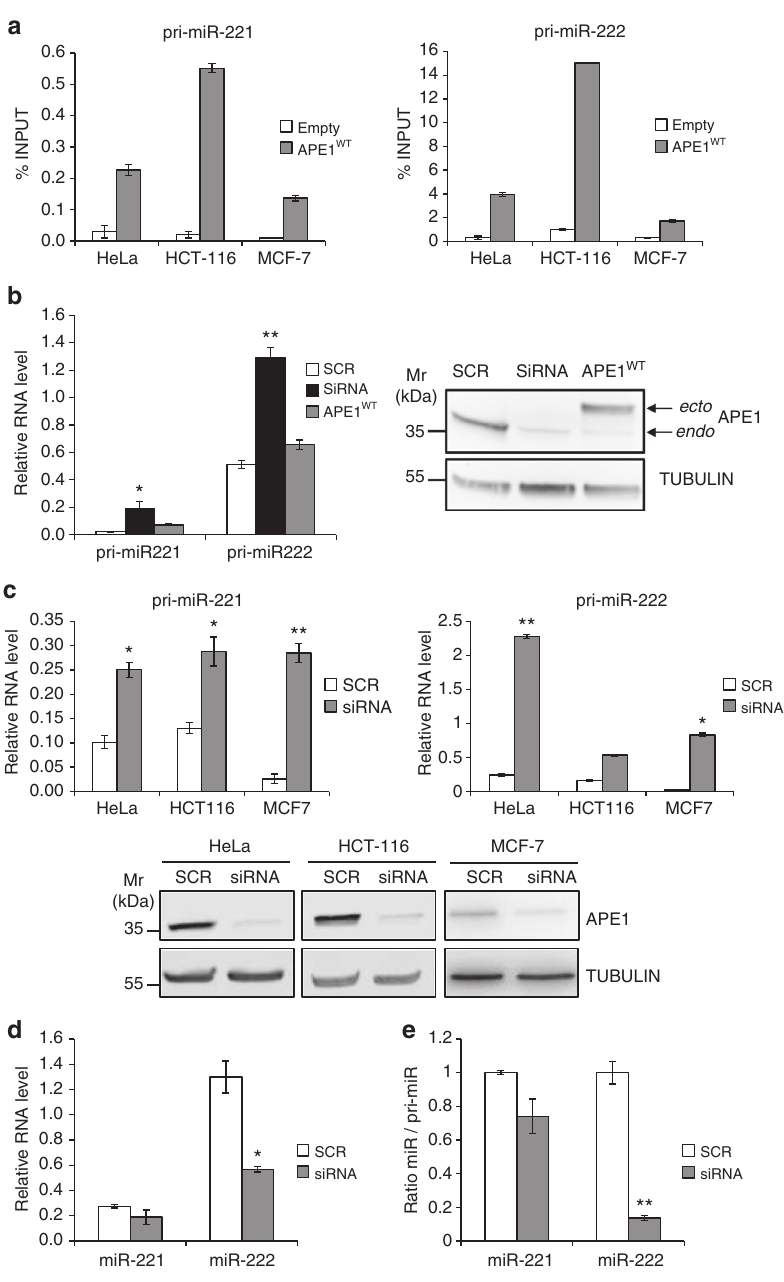
Fig. 2 APE1 binding to pri-miR-221/222. a Validation of APE1 binding to pri-miR-221 and pri-miR-222 in different human cancer cell lines. qRT-PCR of pri- miRs bound by APE1 in different cell lines transfected with either empty vector or with a vector expressing APE1 WT FLAG-tag protein. Data are presented as fold percentage of the amount of immunoprecipitated pri-miR relative to that present in total input RNA. b Pri-miR-221 and pri-miR-222 expression levels evaluated by qRT-PCR analysis of HeLa cell clones silenced for APE1 expression. Total RNA was extracted from HeLa cell clones stably transfected with scrambled siRNA control ( SCR ), with an APE1 siRNA ( siRNA ) and reverse transcribed as described in the Methods section. Histograms show the detected levels of pri-miR-221 and pri-miR-221 normalized to GAPDH levels. Asterisks represent a signi fi cant difference with respect to control (SCR). * P < 0.05, ** P < 0.001, Student ’ s t -test. Right , western blotting analyses of HeLa cell clone extracts silenced for APE1 expression. c Pri-miR-221 and pri-miR- 222 expression levels evaluated by qRT-PCR analysis of different cell lines. Total RNA was extracted from HeLa, HCT-116, and MCF-7 cell lines transiently silenced for APE1 and reverse transcribed. Histograms show the detected levels of pri-miR-221 and pri-miR-221 normalized to GAPDH levels. Asterisks represent a signi fi cant difference with respect to control (SCR). * P < 0.05, ** P < 0.001, Student ’ s t -test. Bottom , representative western blotting analyses to con fi rm APE1 silencing in HeLa, HCT-116, and MCF-7 cells. Tubulin was used as loading control. d Mature miR-221 and miR-222 expression levels evaluated by qRT-PCR analysis of HeLa cells silenced for APE1 expression. Total RNA was extracted from HeLa cell clones stably transfected with scrambled siRNA control ( SCR ), with an APE1 siRNA (siRNA), and reverse transcribed. Histograms show the detected levels of miR-221 and miR-222 normalized to RNU44 levels. Asterisks represent a signi fi cant difference with respect to control (SCR). * P < 0.05, ** P < 0.001, Student ’ s t -test. e Mature miR to pri-miR ratios in HeLa cells clones silenced for APE1 expression. Mature miR-221 and miR-222 were measured by qRT-PCR analysis, normalized to RNU44, and expressed relative to GAPDH-normalized pri-miR-221/222. Asterisks represent a signi fi cant difference with respect to control (SCR). * P < 0.05, ** P < 0.001, Student ’ s t